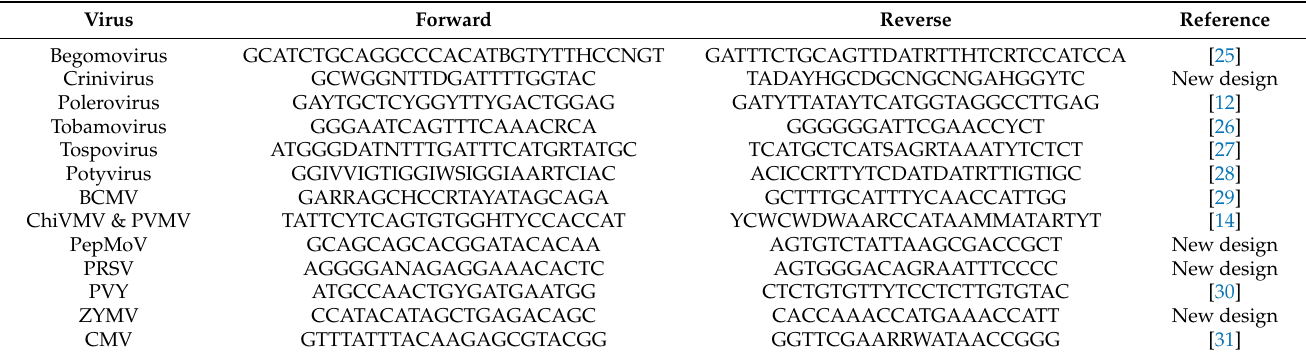
Table 1. Primer sets for diagnosis of viral diseases in collected